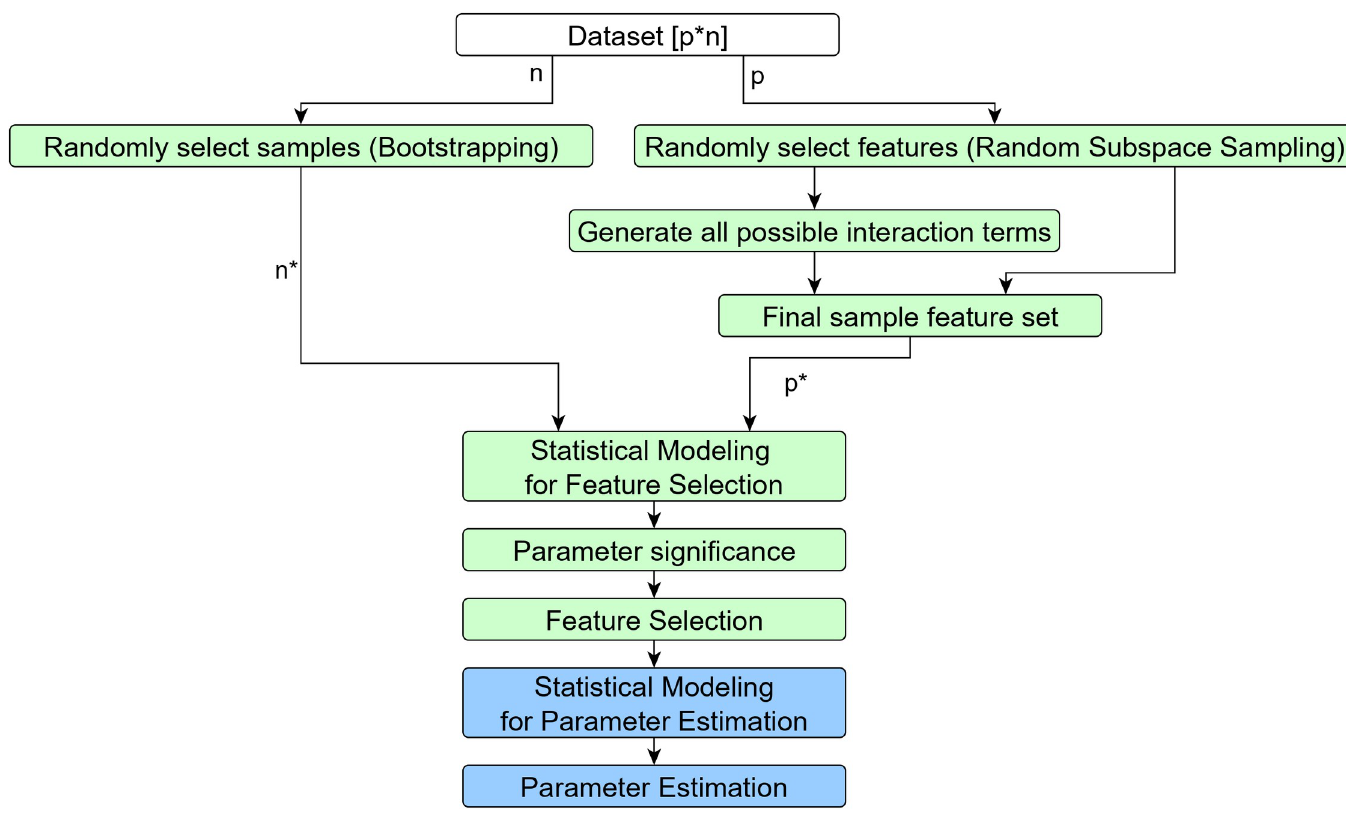
Fig 2. Graphical representation of HDSI methodology. p: number of features in the dataset, n: sample size of the dataset, p � : number of features (including sampled features and its interaction terms) used for modeling and n � : each bootstrapped dataset has the same sample size n used for modeling. The green colour steps represent the proposed method and blue colour steps represent the process to estimate the coefficient of selected